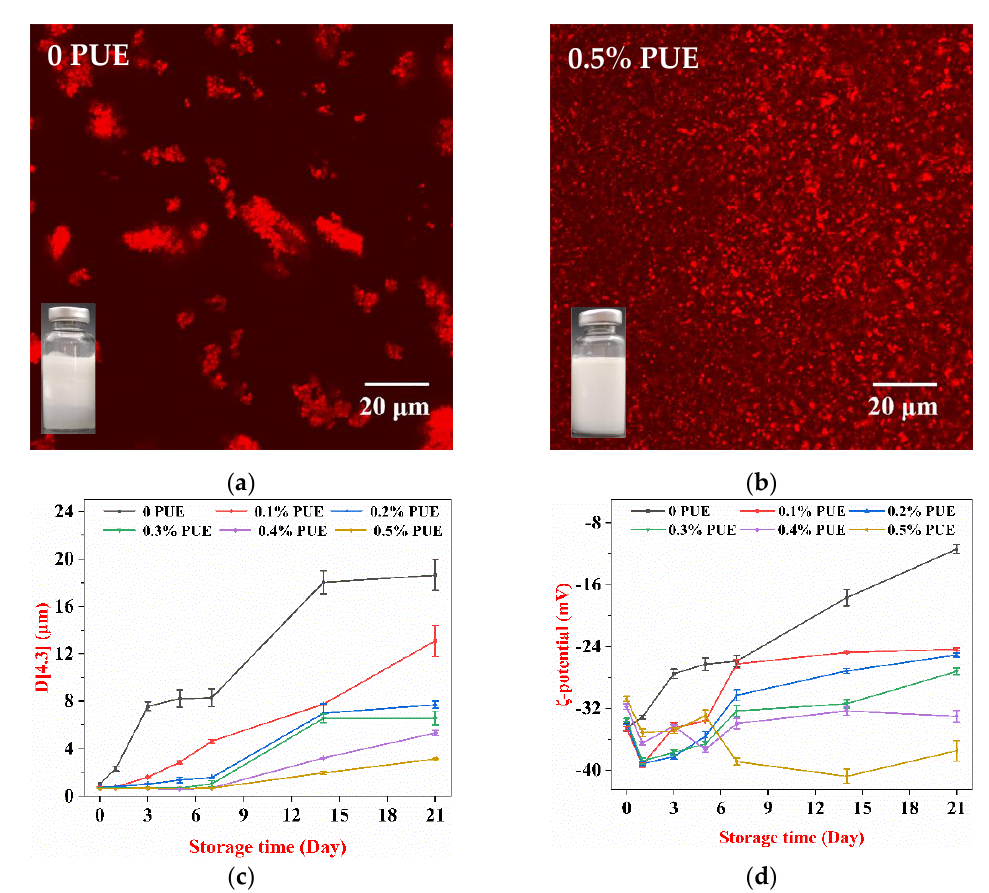
Figure 2. Properties of emulsions stabilized using WPI only (0 PUE) or WPI – PUE composites with different concentrations of PUE (from 0.1% to 0.5%) during 21 days of storage. ( a ) Confocal micrographs of emulsions and visual appearance (bottom left) for WPI emulsion; ( b ) confocal micrographs of emulsions and visual appearance for WPI – PUE emulsion 0.5% PUE, the scale bar corresponds to 20 µm; ( c ) mean particle diameter; and ( d ) ζ -potential.